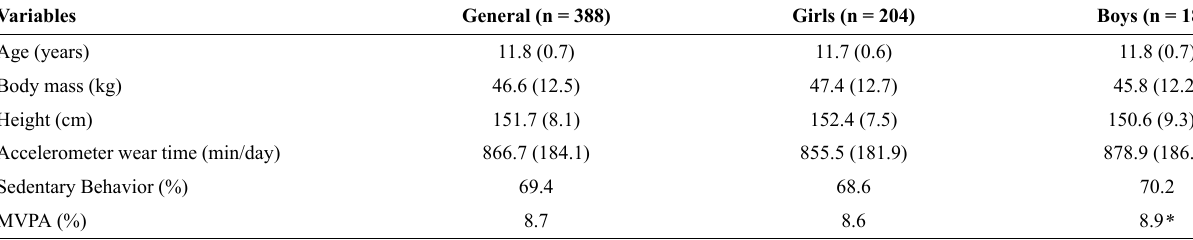
Table 1 - Sample characteristics of the studied population according to gender.